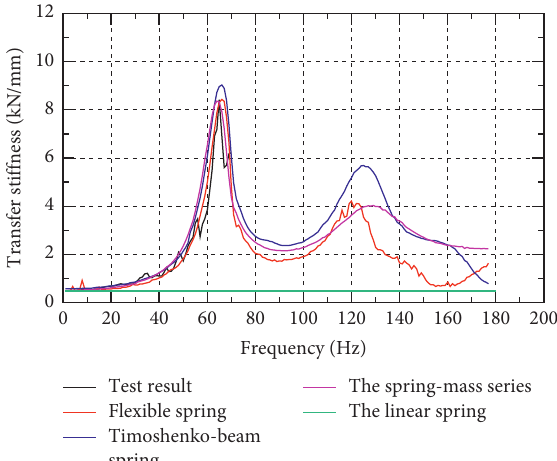
Figure 11: Comparison of dynamic stiffness between equivalent models and